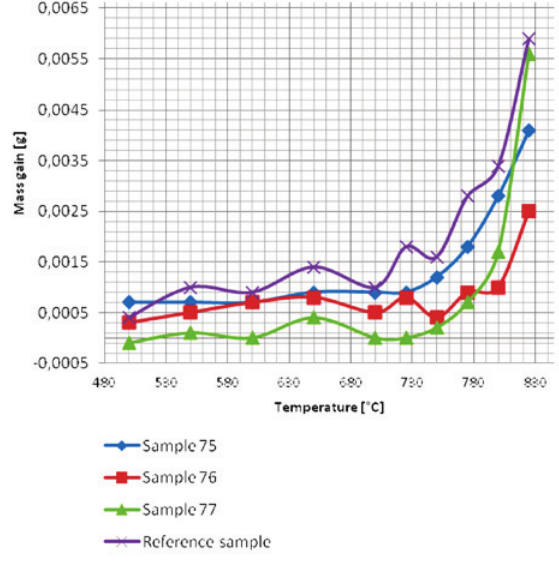
fig. 11. Gain in mass depending on temperature (Urbahs et al .